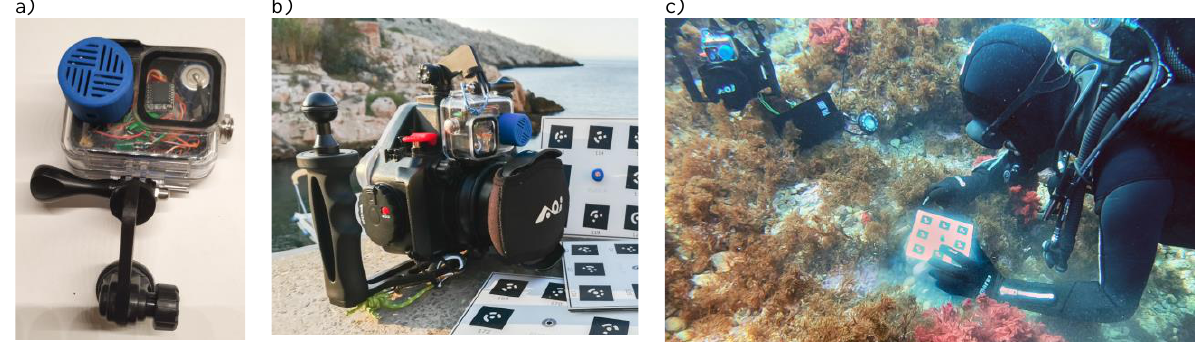
Figure 1 . Experimental testing of the prototype module for synchronized depth measurements based on a pressure sensor. The developed prototype module (a) mounted on an Olympus underwater housing (b) and during the underwater tests